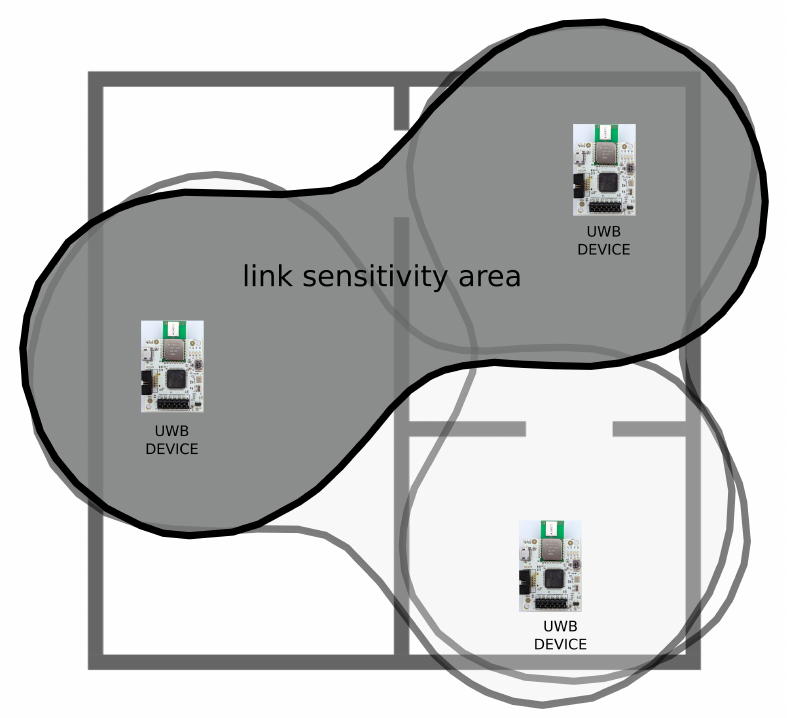
Figure 2. Graphical representation of deployment of three UWB devices in an apartment with link sensitivity areas visualized by Cassini oval